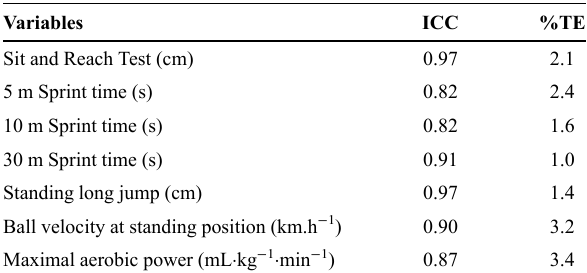
Table 1 - Reliability of the general physical fitness tests and throwing velocity.